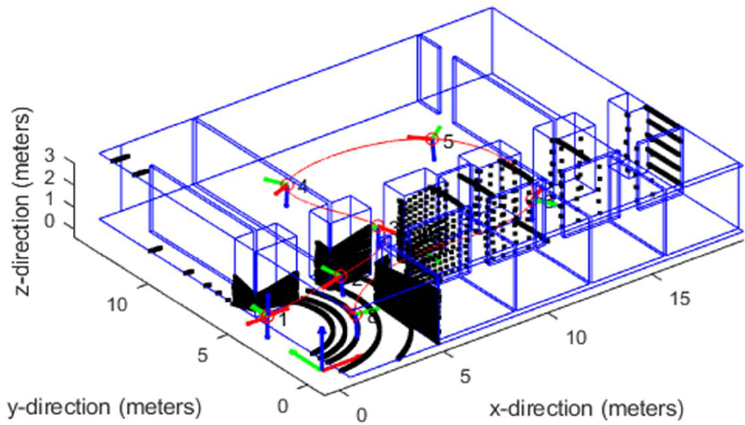
Figure 6. Schematic diagram of the trajectory of IMU and LiDAR. Table 1. Motion trajectory generation control point parameters.